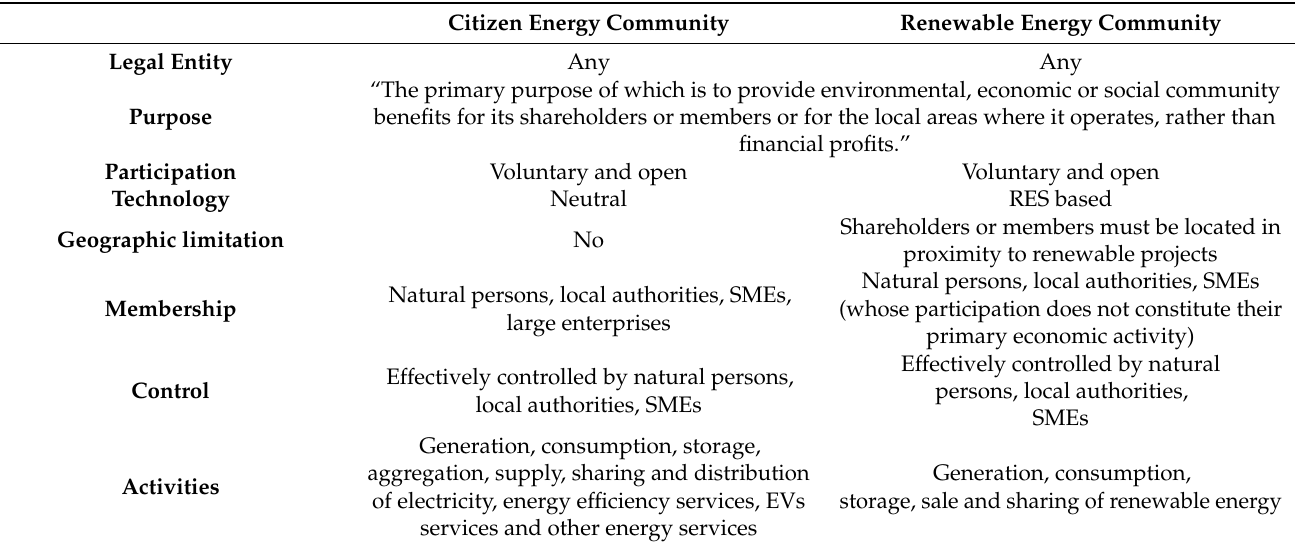
Table 1. Comparison between RECs and CECs